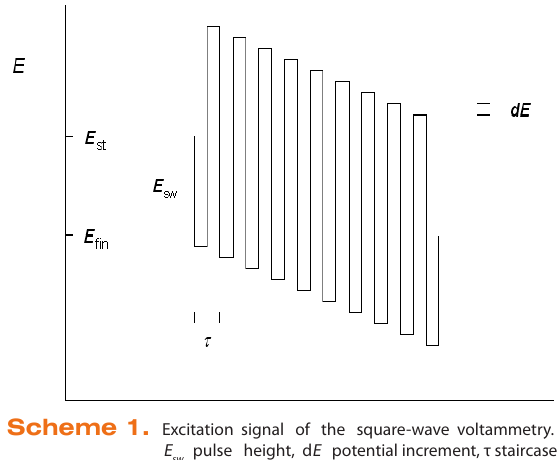
Scheme 1. Excitation signal of the square-wave voltammetry. E